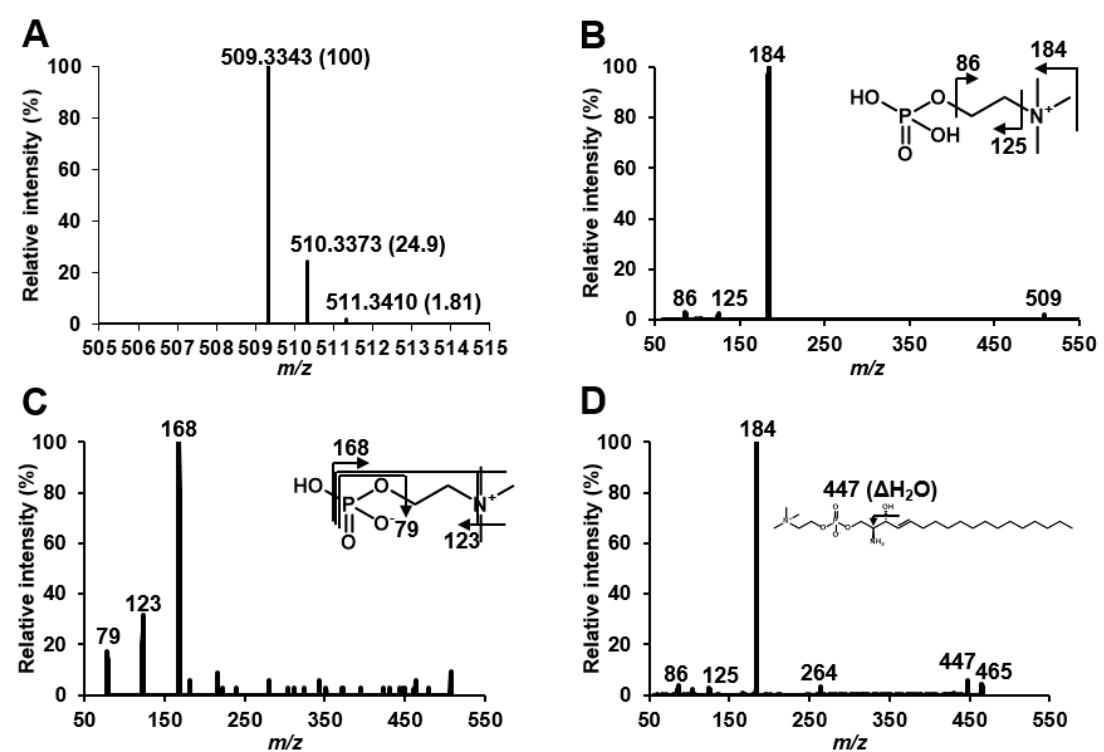
Figure 2. Mass spectra of Lyso-SM-509 and SPC. ( A ) Typical high-resolution mass spectrum of the serum of patient with NPC. ( B ) Typical product ion spectrum of Lyso-SM-509 on positive ion mode. ( C ) Typical product ion spectrum of Lyso-SM-509 on negative ion mode. ( D ) Typical product ion spectrum of SPC on positive ion mode.